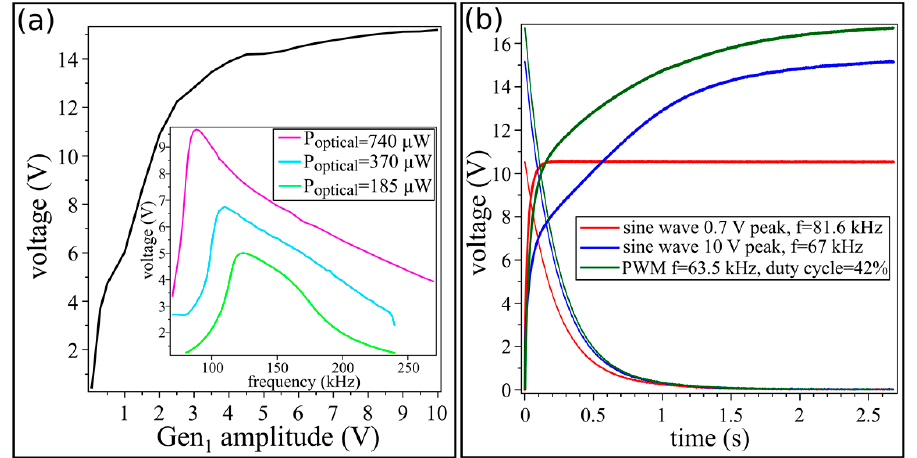
Figure 6. ( a ) PDC amplitude characteristic at f = 74 kHz, the inset shows the frequency response of PDC for different values of average optical power; ( b ) the step response of PDC for different laser-driving signals of LDC.